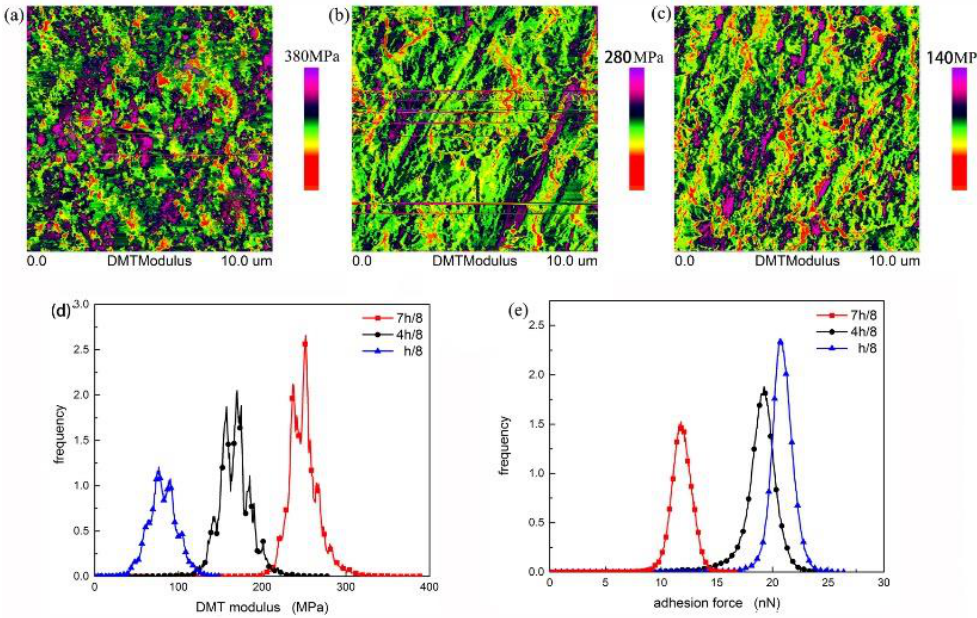
Figure 7. Quantitative nanomechanical property mapping images for 7/8 h ( a ), 4/8 h ( b ) and 1/8 h ( c ) of the continuous gradient IPN composite. The modulus images were taken after an absolute calibration process. Distribution histogram of the Derjaguin–Muller–Toporov (DMT) modulus ( d ) and adhesive force ( e ) at the corresponding selection regions.